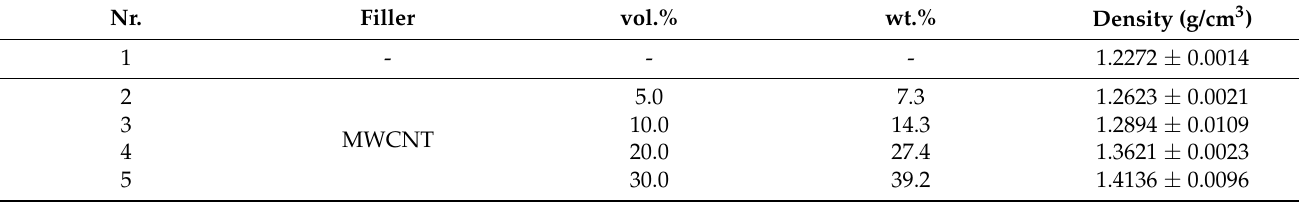
Table 1. Prepared compositions of PBSA composites and measured density